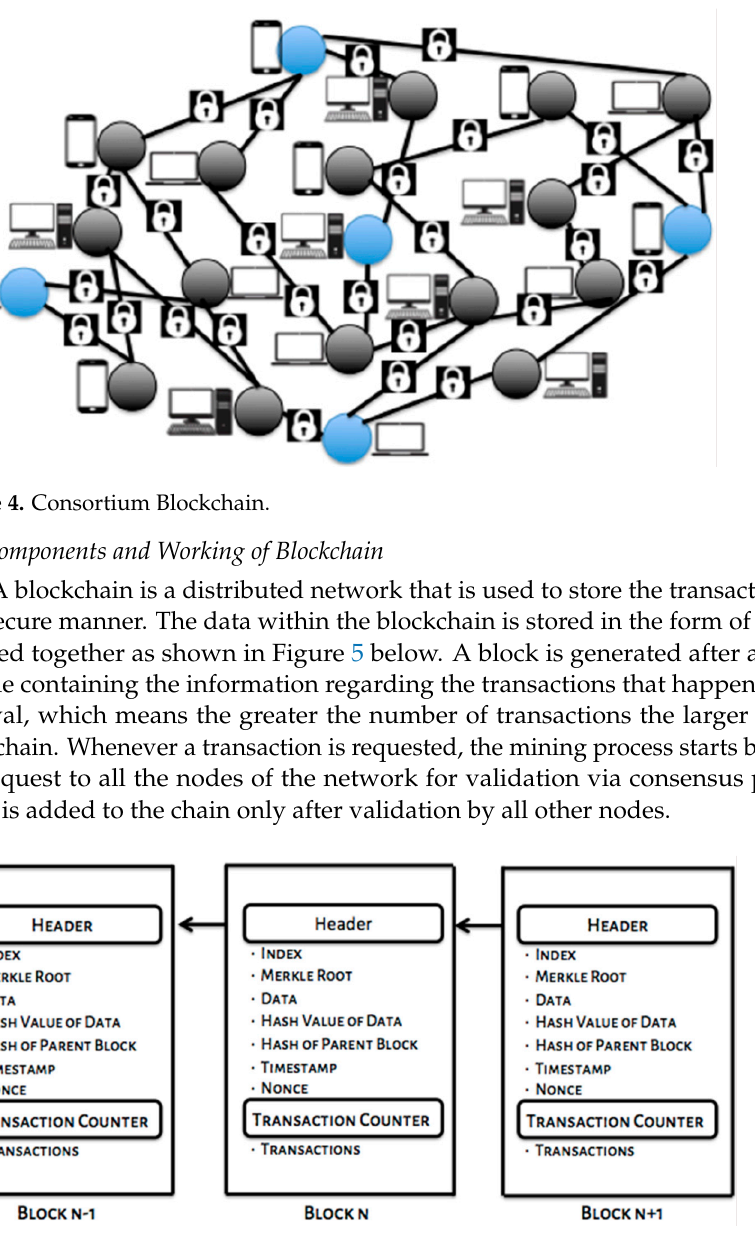
Figure 5. Connected Blocks in a